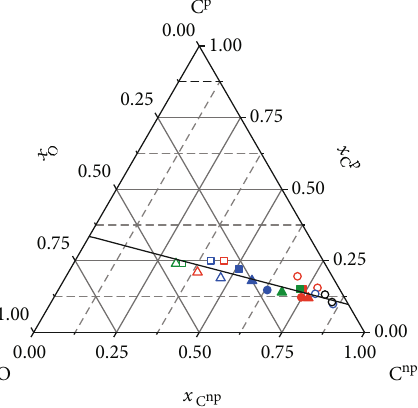
Figure 4: Cosine of the water contact angle cos ð θ the adsorbate layer thickness δ . Results for di ff erent substrates: gold (circles), steel (triangles), and titanium (squares). Pretreatment: no- oil (open symbols) and with oil ( fi lled symbols). Cleaning: CCC (blue), AAA (red), III (green), and NC (black). The results for gold were obtained in the present work; the other results are taken from Becker et al. [20]. The error bars of the adsorbate layer thickness are within the symbol